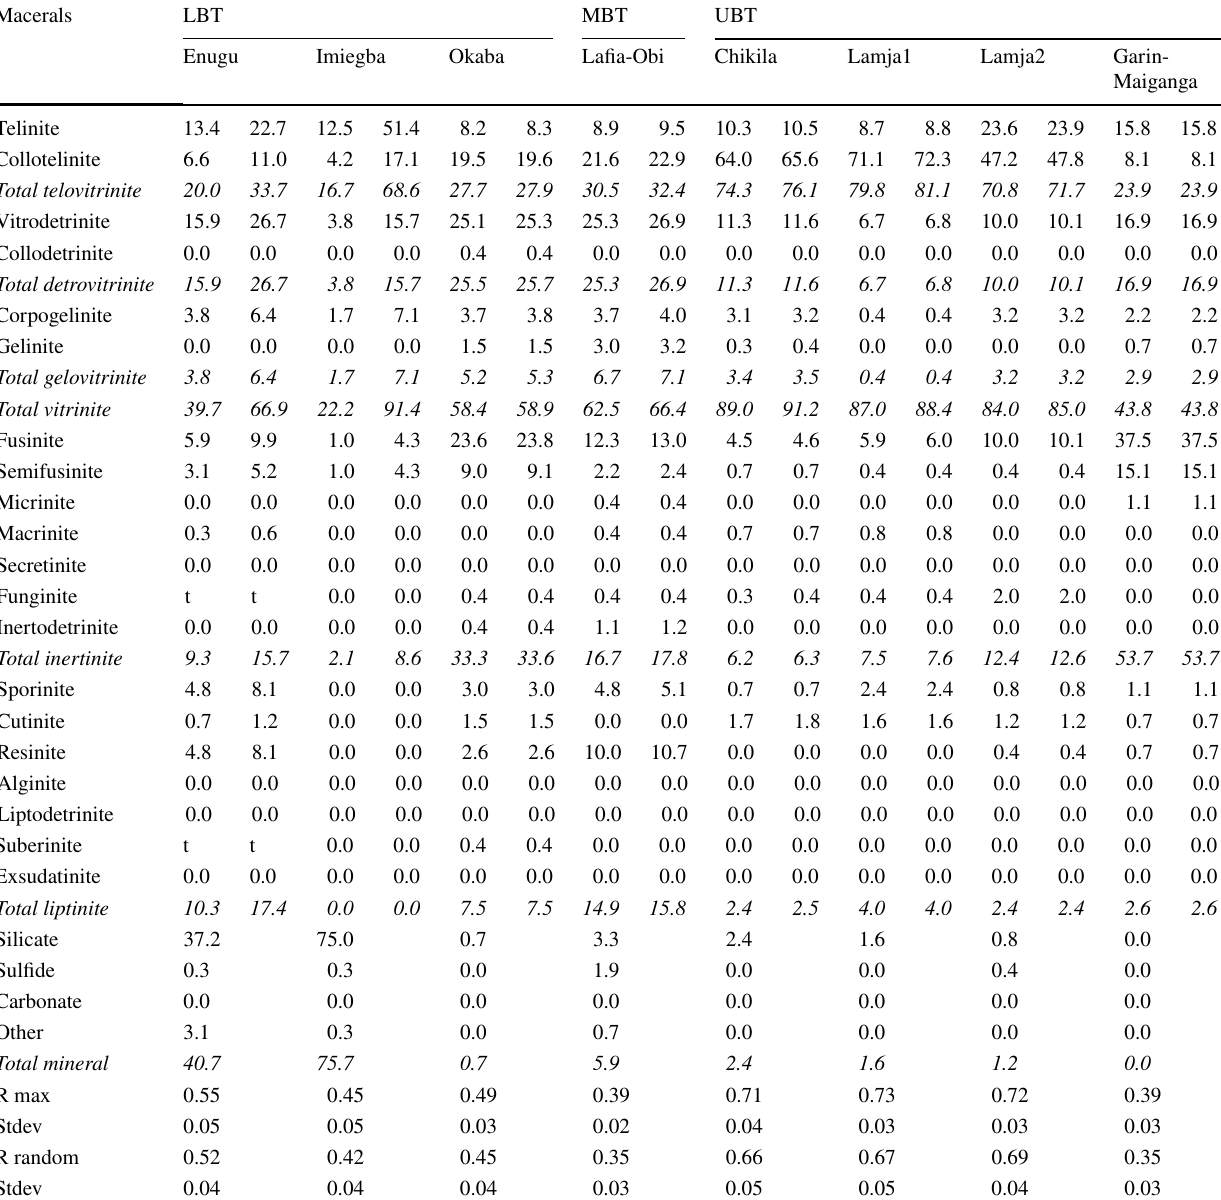
Table 2 Maceral composition (mineral matter free basis, mmf) and mean reflectance of Cretaceous coals from the Benue Trough. Macer- als, subtotals of vitrinite submacerals (in italics), and totals of mac- eral groups and of minerals (in italics) along with the vitrinite maxi-